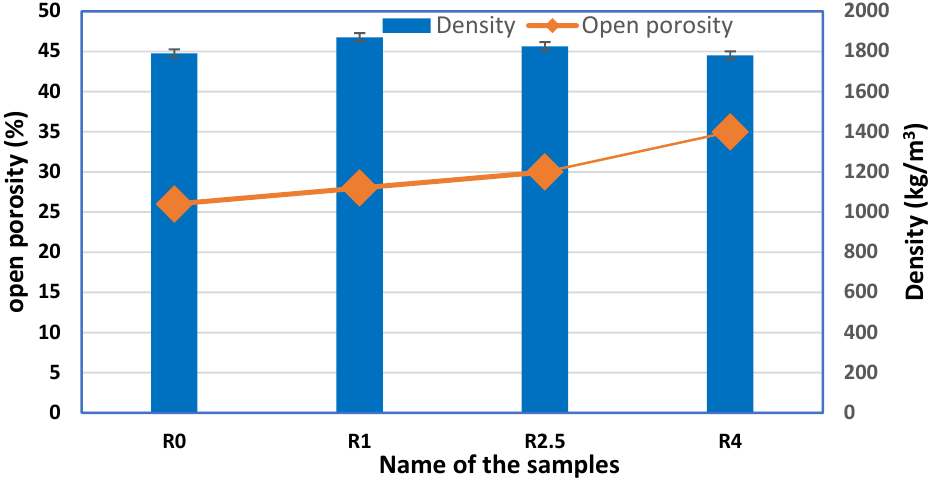
Figure 5. Cob’s density and open porosity variation versus Sargassum muticum content.